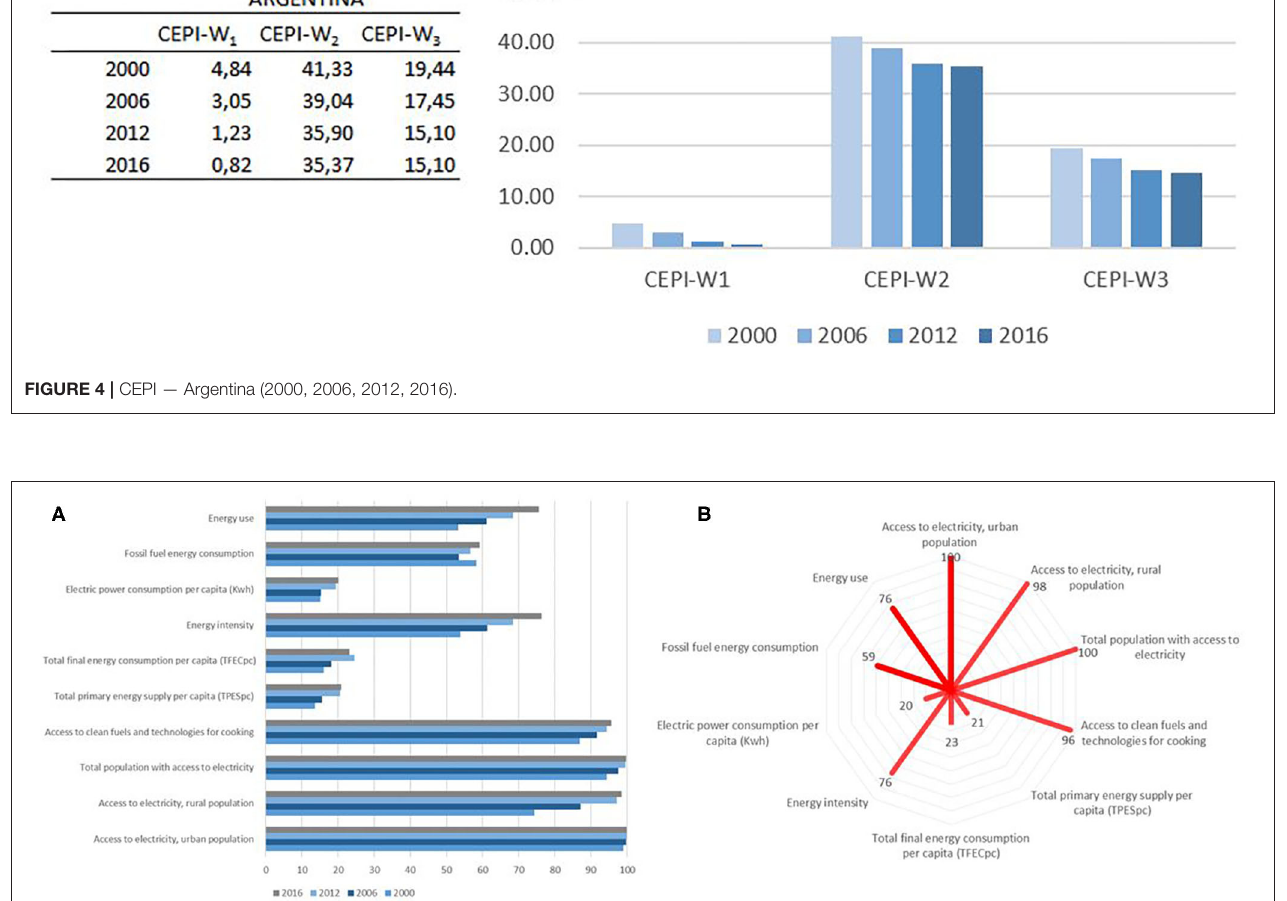
Frontiers in Sustainable Cities |